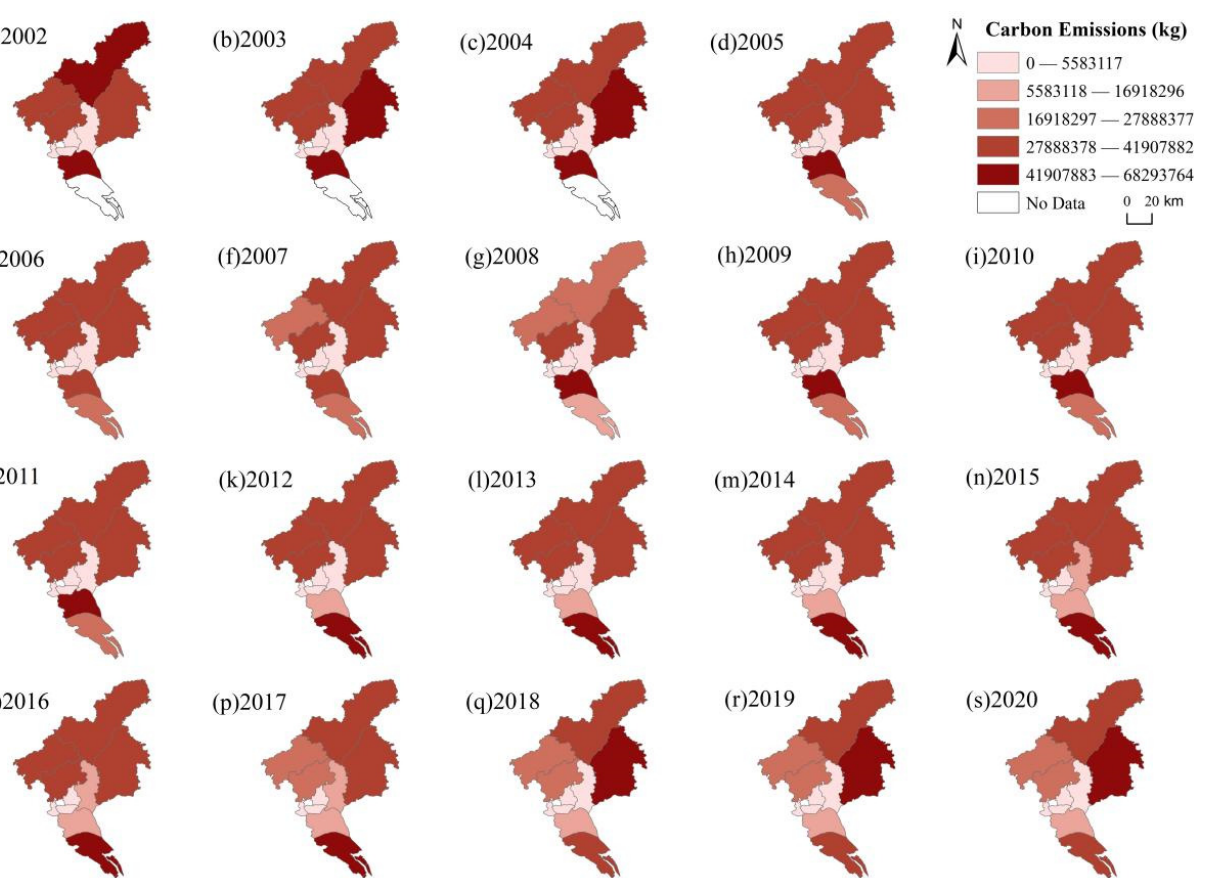
Figure 6. Carbon emissions of urban agriculture in Guangzhou’s districts from 2002 to 2020.